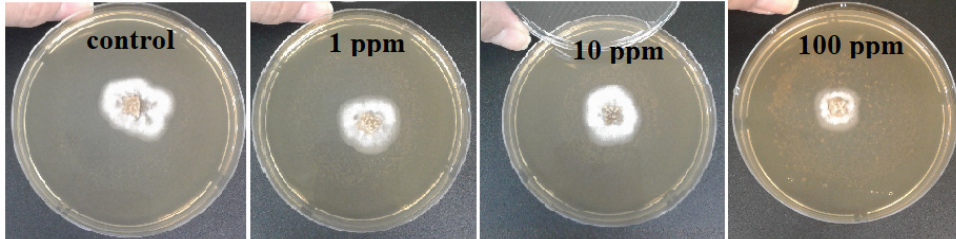
Figure 3. Effect of different concentrations of Ag NP on the growth of P. concavum at 9 days of age: control and treatments with Ag NPs of 0 (as control) 1, 10, and 100 ppm concentrations, agar dilution method.